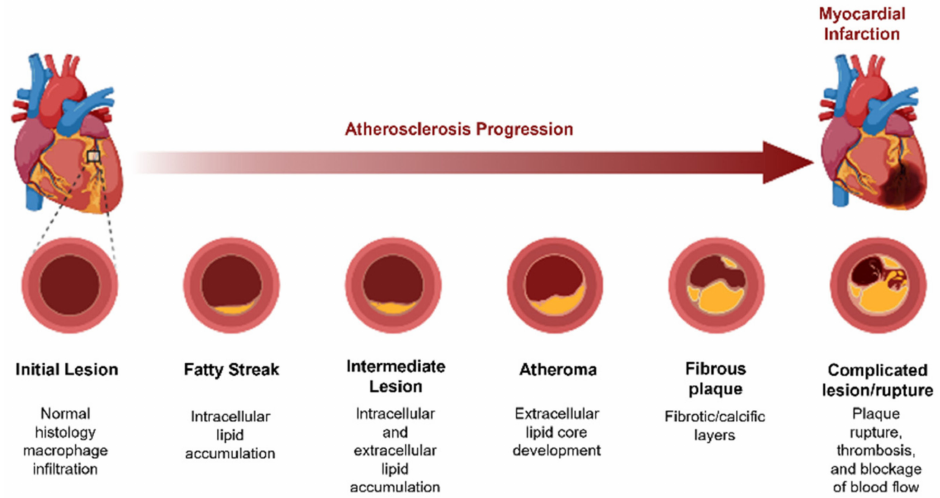
Figure 1. Coronary artery disease: scheme of atherosclerosis progression leading to myocardial infarction (Created in